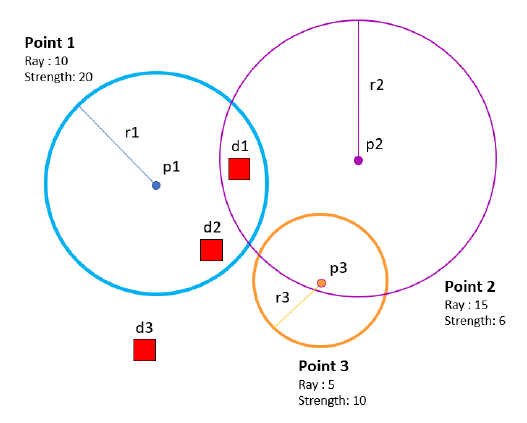
Figure 9. SURF geometrical distortion detection